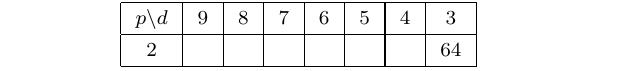
Table 42 . Number of E (11;7) -branes in the p -brane multiplet in d